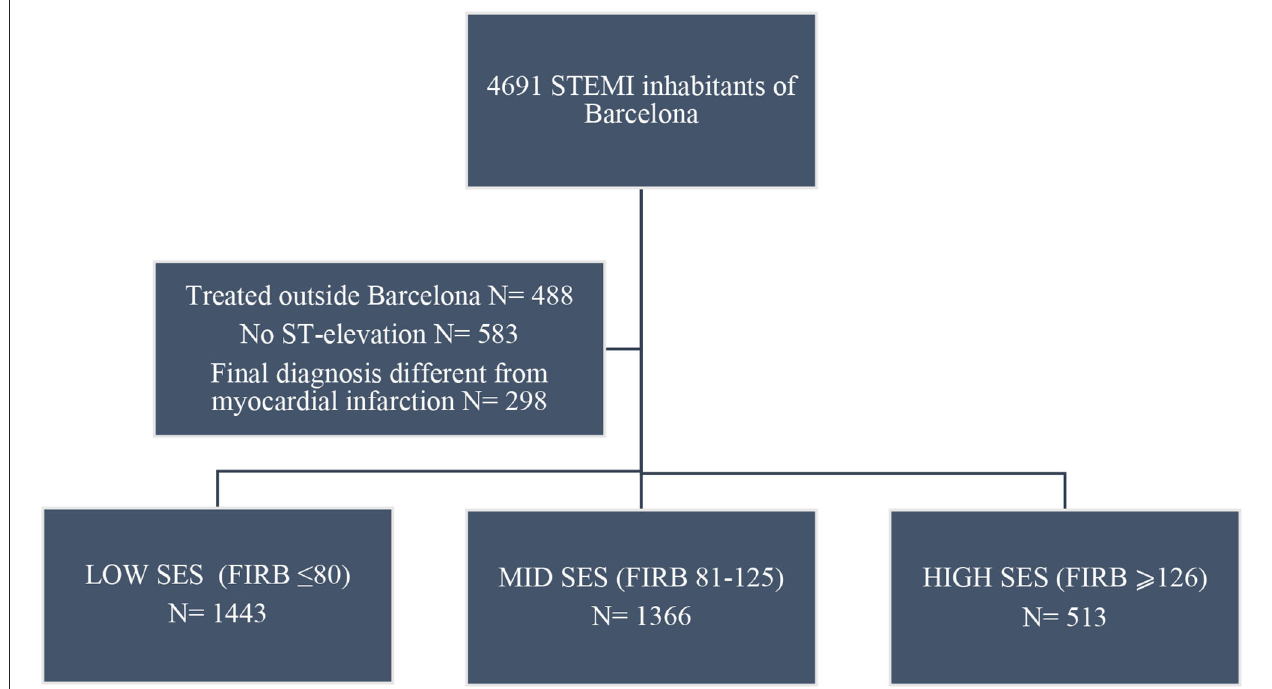
FIGURE 1 | “Codi IAM” ST-elevation myocardial infarction (STEMI) patient inclusion flowchart.